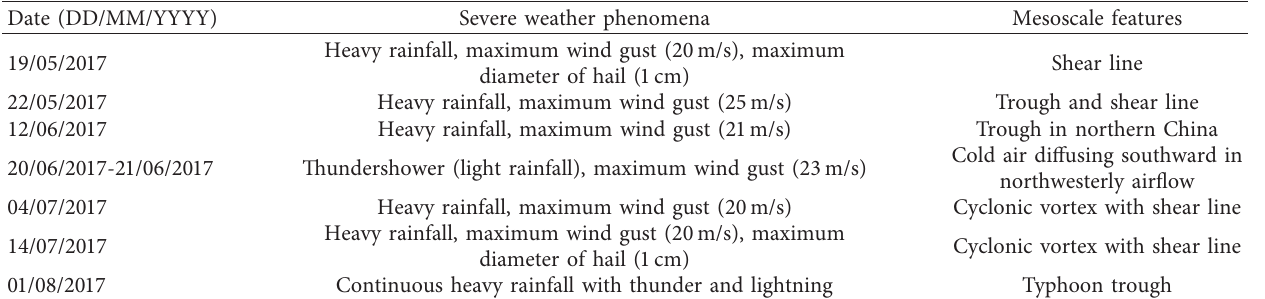
Table 1: Characteristics of the 7